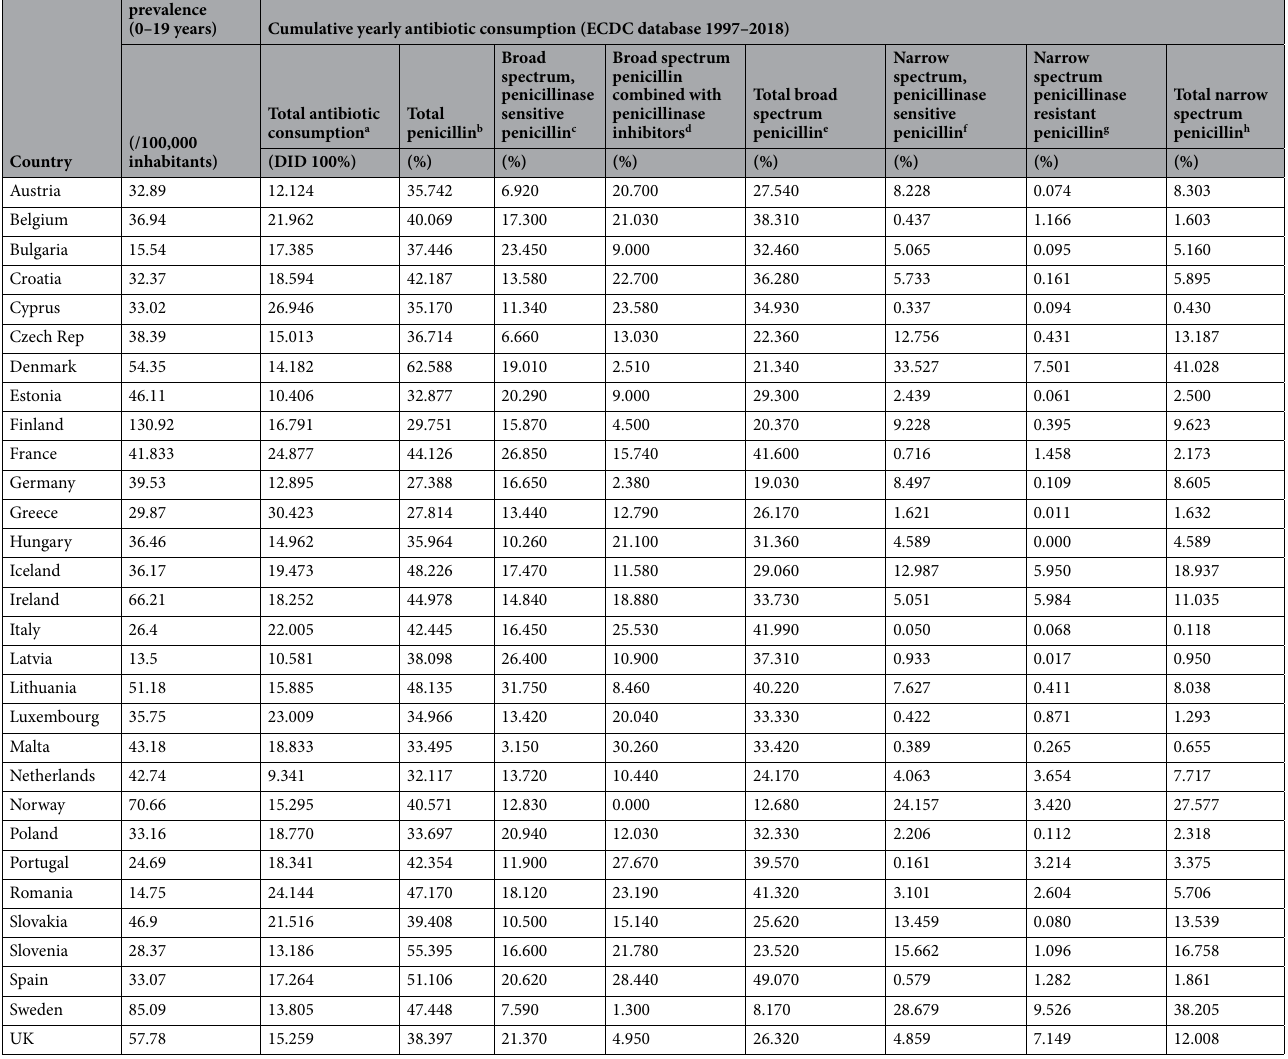
Table 3. Prevalence of T1DM for 0–19 years and penicillin consumption (ECDC database 1997–2018). Prevalence data of T1DM for 0–19 years calculated for 100,000 inhabitants/country (Diabetes Atlas edition 9) compared to penicillin consumption (1997–2018), expressed in % of the total consumption (SUM) in DID, according to the ECDC (European Centre for Disease Prevention and Control) database. ATC code: a J01;